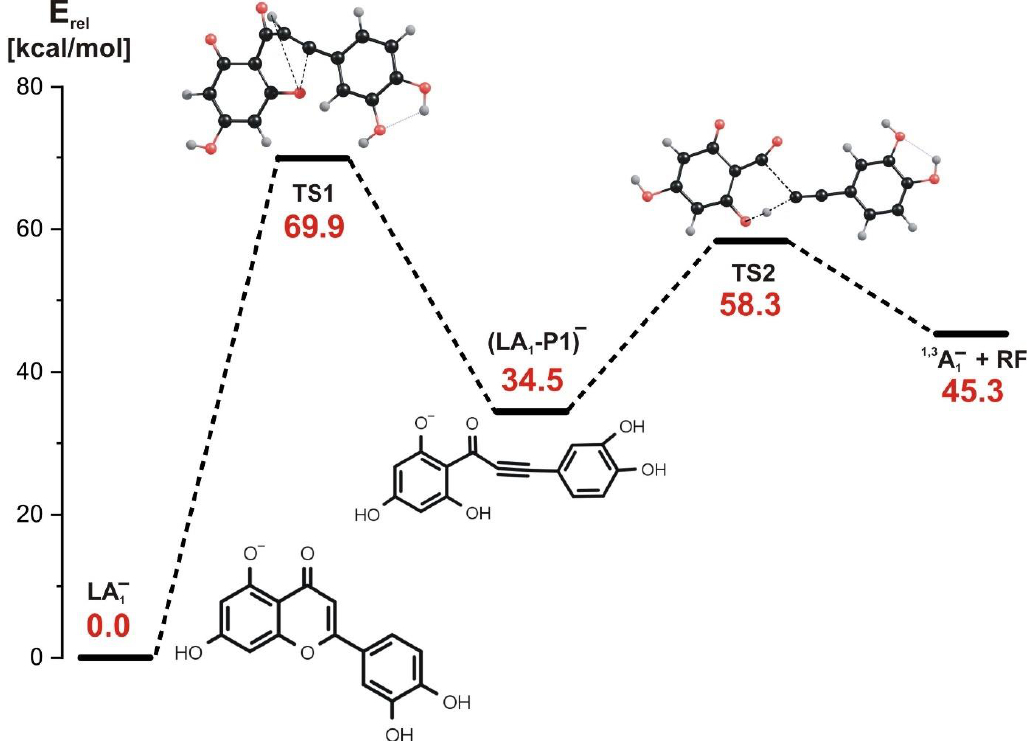
Figure 5. Energy profile for the 1,3-retrocyclization of LA 1- proceeding according to the stepwise mechanism and resulting in the formation of 1,3 A 1- negatively charged product. The energies of the transition states (TS1 and TS2), intermediate product ((LA 1 -P1) - ), and the separated products ( 1,3 A 1- anion and the remaining neutral fragment RF) are given (in kcal/mol) as the relative values (E rel ) with respect to the energy of the LA 1- substrate (taken as zero).